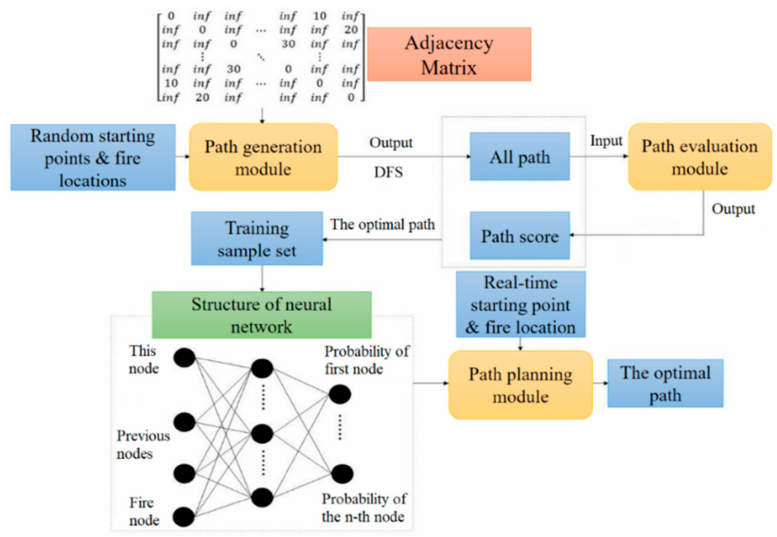
Figure 9. Training of rescue route planning network.